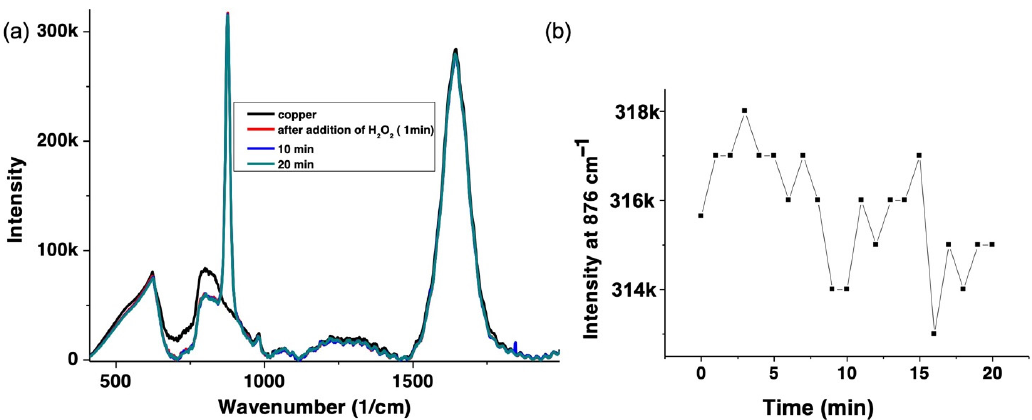
Figure 6. ( a ) Raman spectra of CuSO 4 (1 mM) (black) and after addition of H 2 O 2 (100 mM). Data points are shown at 1 min (red), 10 min (blue) and 20 min (green). ( b ) shows the intensity of the 876 cm − 1 peak (H 2 O 2 band (O-O band)) over 20 min detected by Raman spectroscopy with excitation at 785 nm. This indicates that the concentration of H 2 O 2 is reduced during the reaction as outlined in Figure 1.